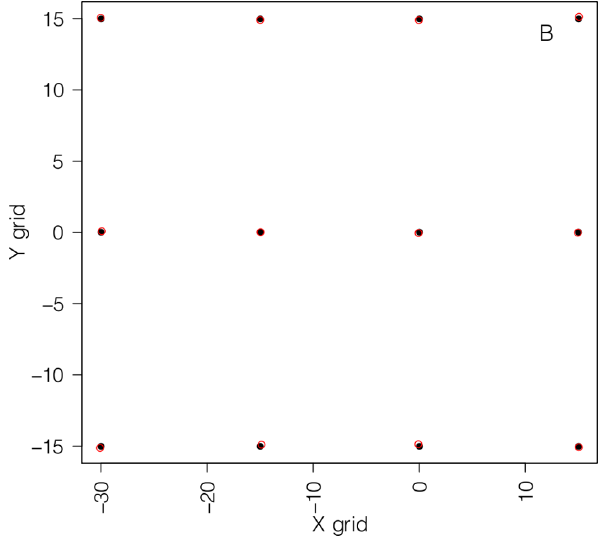
Figure 4. A undistorted reference grid (black) and prediction (red) from the distorted matrix extracted from the image of the checkered frame in Figure 3.